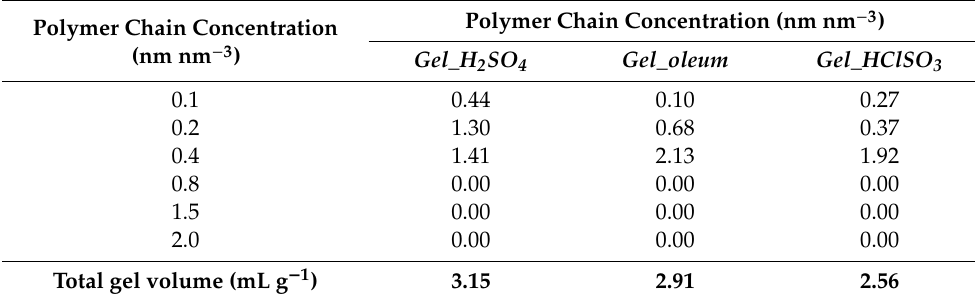
Table 2. ISEC characterization of Gel_H 2 SO 4 , Gel_oleum , Gel_HClSO 3